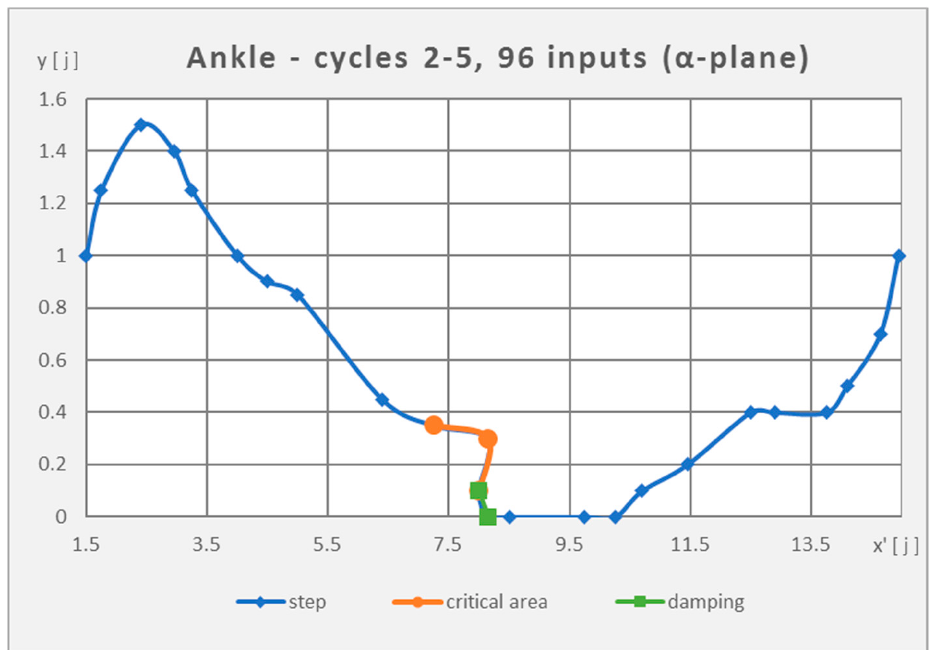
Figure 3. Ankle trajectory (the second step).